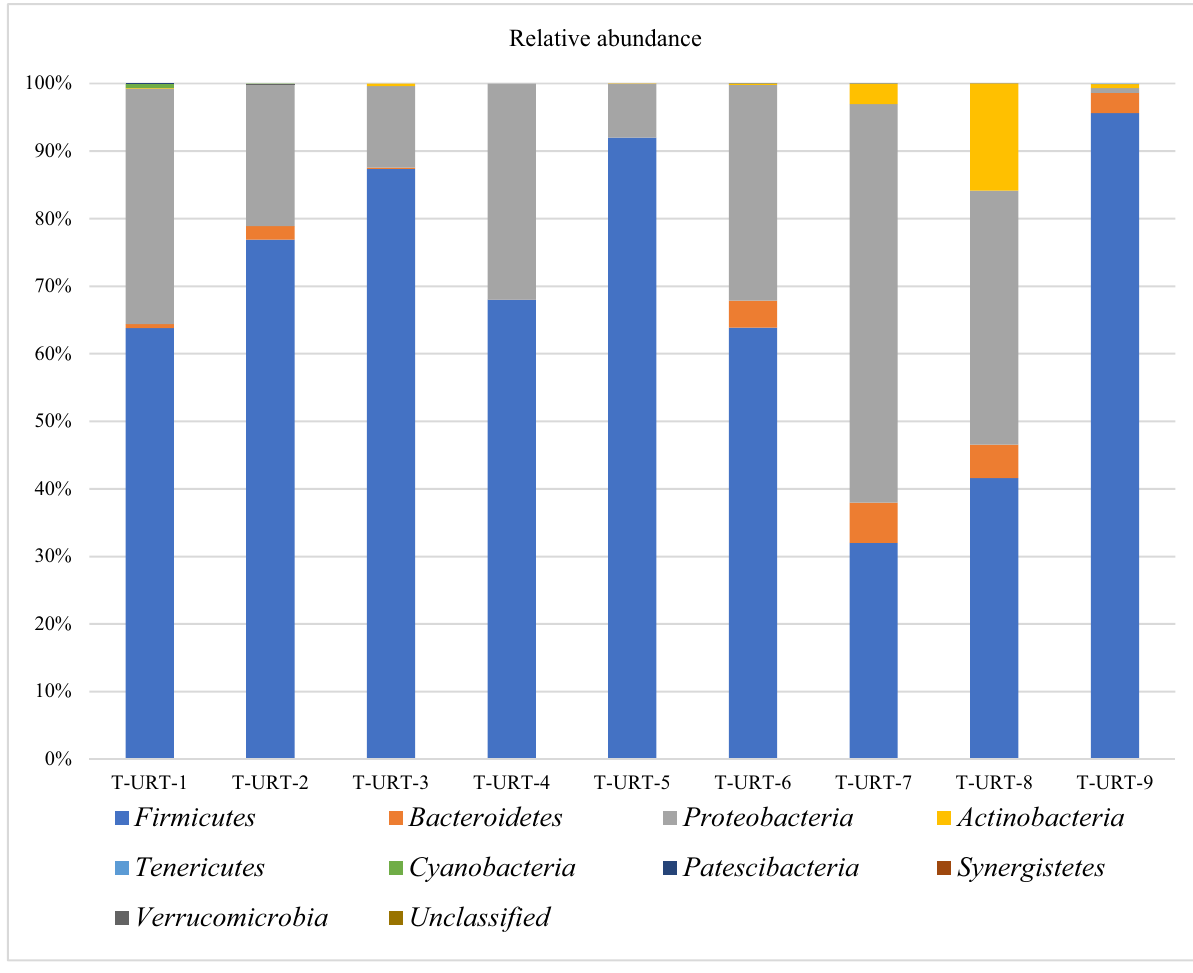
Figure 1. Taxonomic diversity plot showing the relative abundance of taxa at the phylum level in each